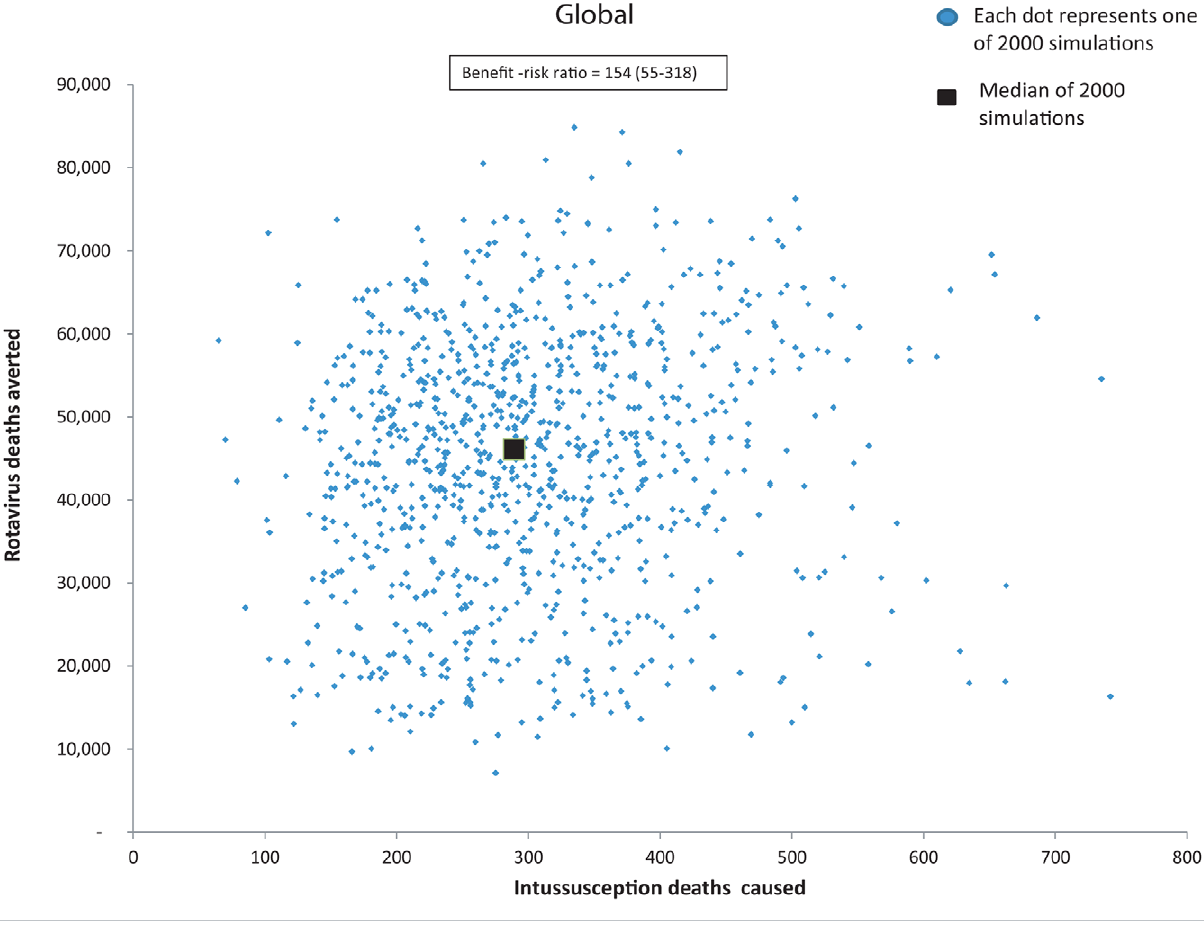
Figure 3. Global analysis of the relationship between esimated number of rotavirus gastroenteritis deaths avoided versus intussusception deaths caused by removal of the age restrictions for rotavirus vaccination. These estimates are from 2,000 simulations with each blue dot representing a potential estimate of rotavirus deaths prevented (y-axis) versus intussusception deaths caused (x-axis) from removal of the age restrictions given the uncertainty on the parameters in the model: rotavirus mortality, vaccine efficacy, vaccine coverage, intussusception incidence, intussusception risk from vaccine, and intussusception fatality. The black square represents the median estimate.